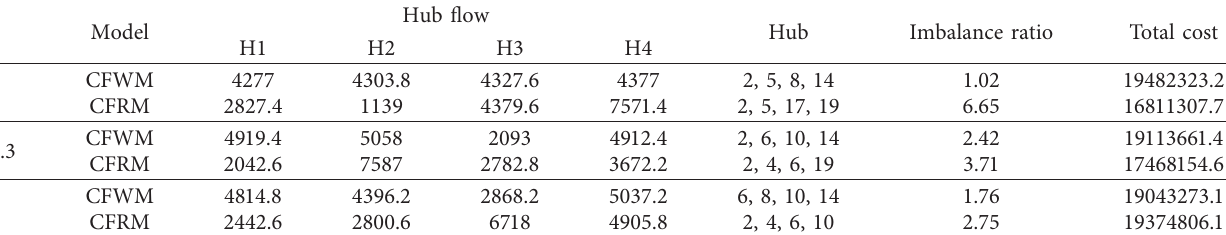
Table 8: Impact of congestion function parameter τ on model